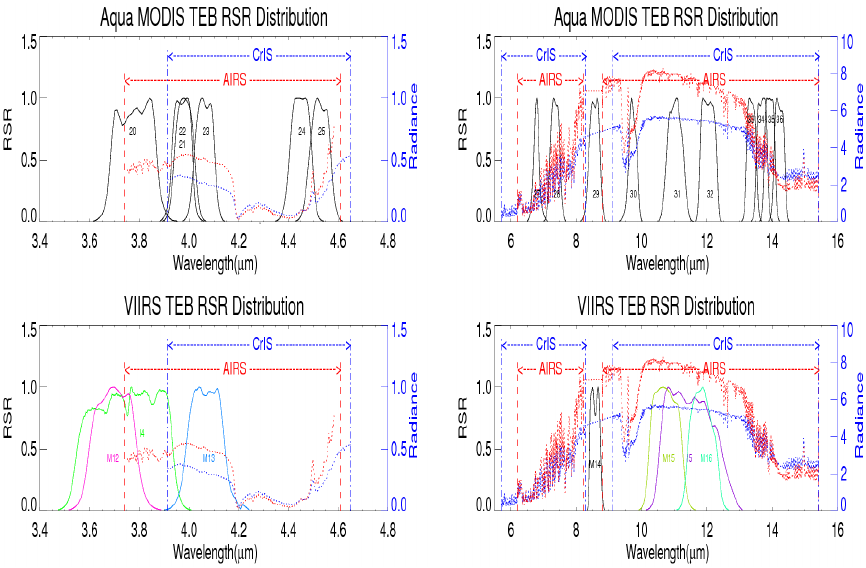
Figure 1. Spectral distribution of VIIRS and MODIS TEBs, as well as AIRS and CrIS spectra coverage. (radiance unit: W/m 2 / μ m/sr).